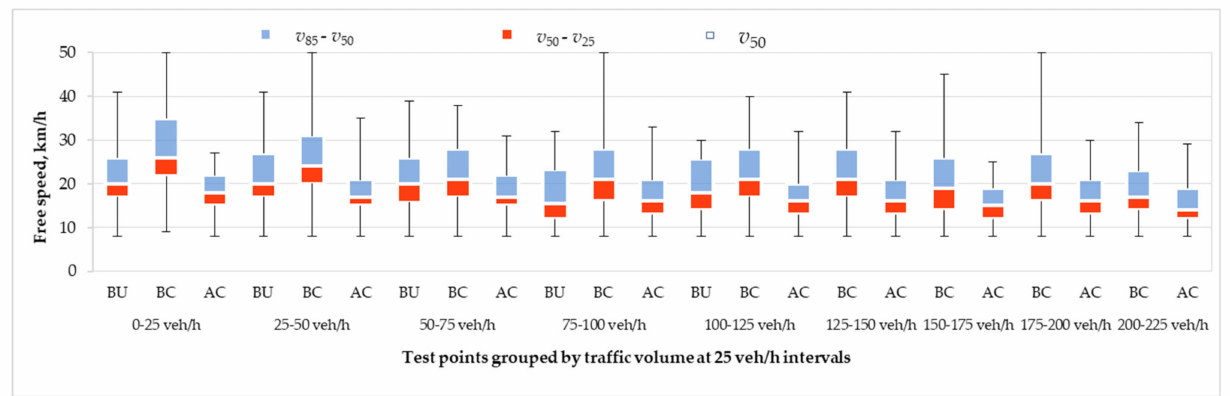
Figure 10. Summary of speed range analysis before and after upgrading, on the approach to and after the choker—data obtained in testing ground No. 3 (BU—before upgrading, BC—before choker, AC—after choker). Source: own work of the